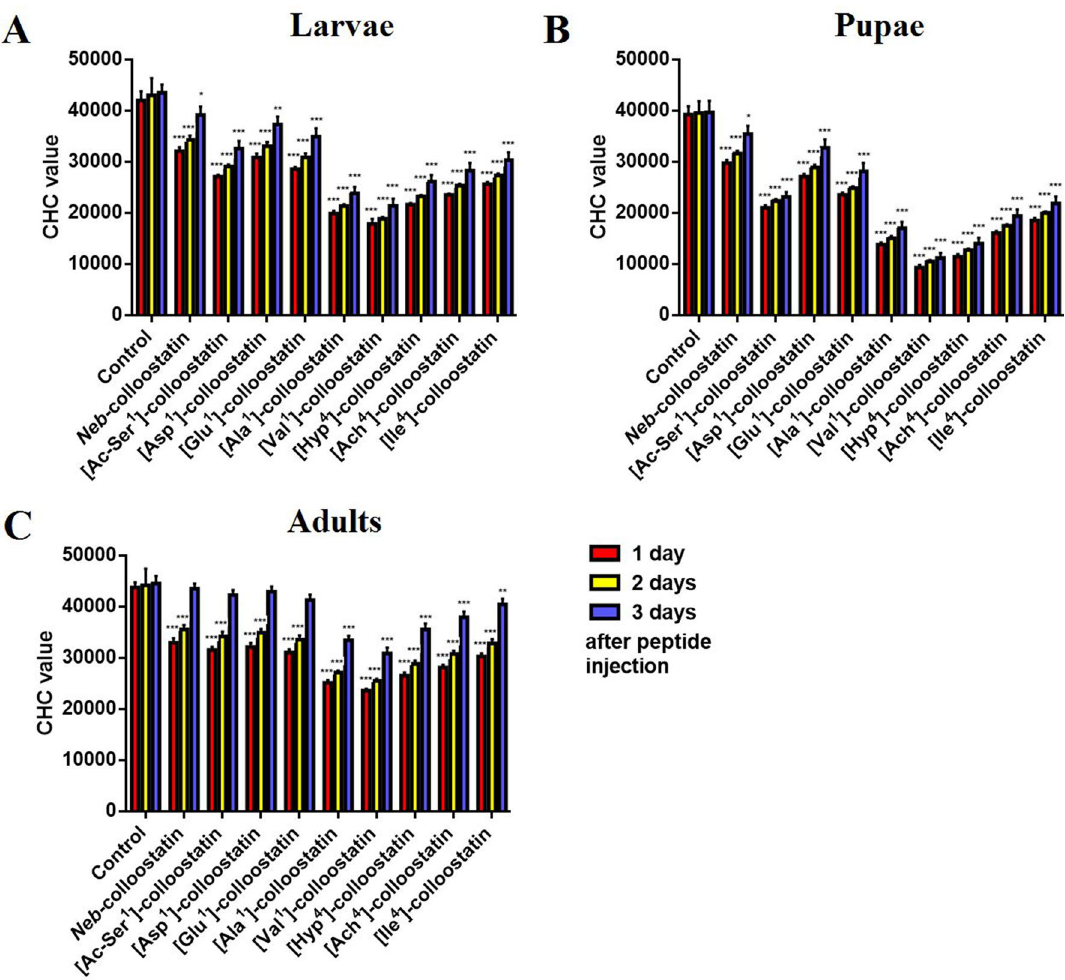
Figure 1. The circulating hemocyte count in T. molitor larvae ( A ), pupae ( B ) and adults ( C ) following an injection of Neb -colloostatin or one of its analogs at doses of 2 ng of peptide per insect. The values shown are means ± S.D. The results that are significantly different from those of the control group are indicated: p < 0.5 (*), p < 0.05 (**), and p < 0.005